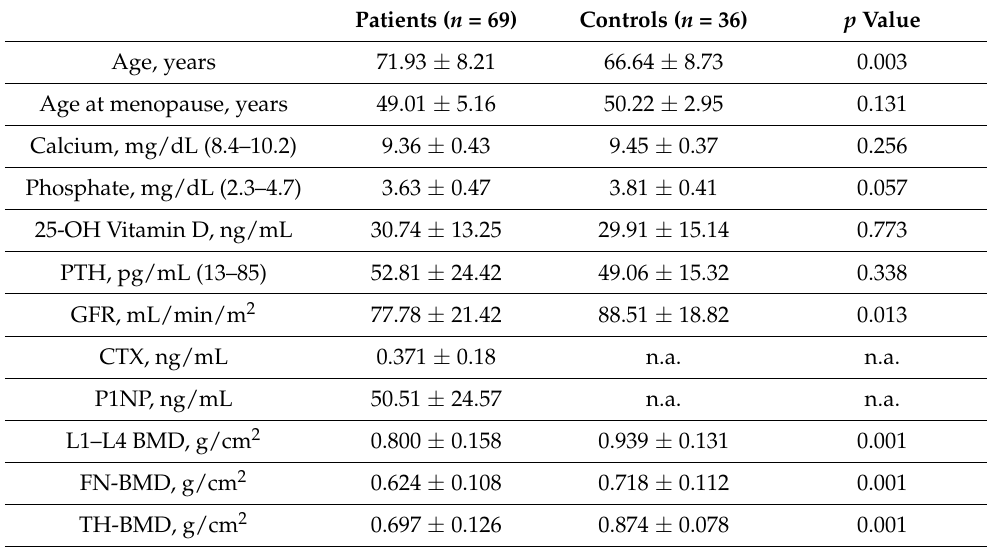
Table 1. Baseline demographic, clinical, and laboratory characteristics of the study population.